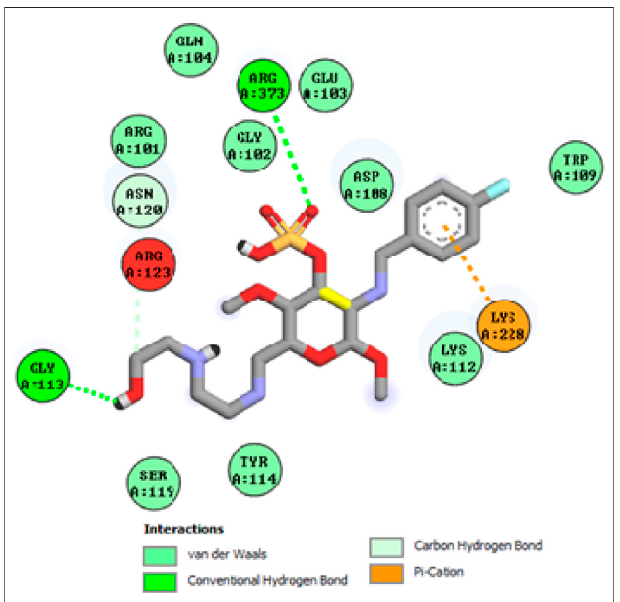
FIGURE 9 | Interaction of compound 2e in the binding pocket of 1Z11 receptor.